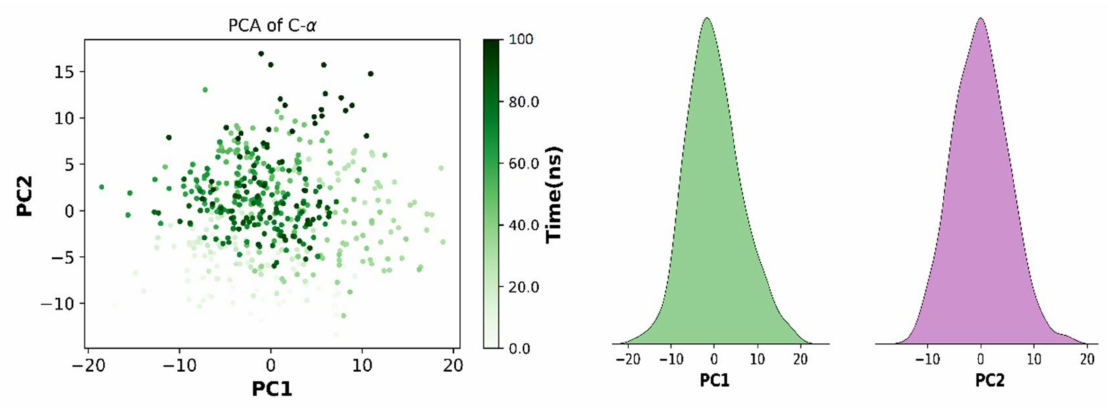
Figure 16. The correlation between protein variables and two top PCs. Correlation matrices are also the correlation coefficients between variables and PCs. In Pearson’s cross-correlation, the percent of variance in a protein variable is explained by PCs. Figure 17 is depicting the Pearson correlation graph for NEK7